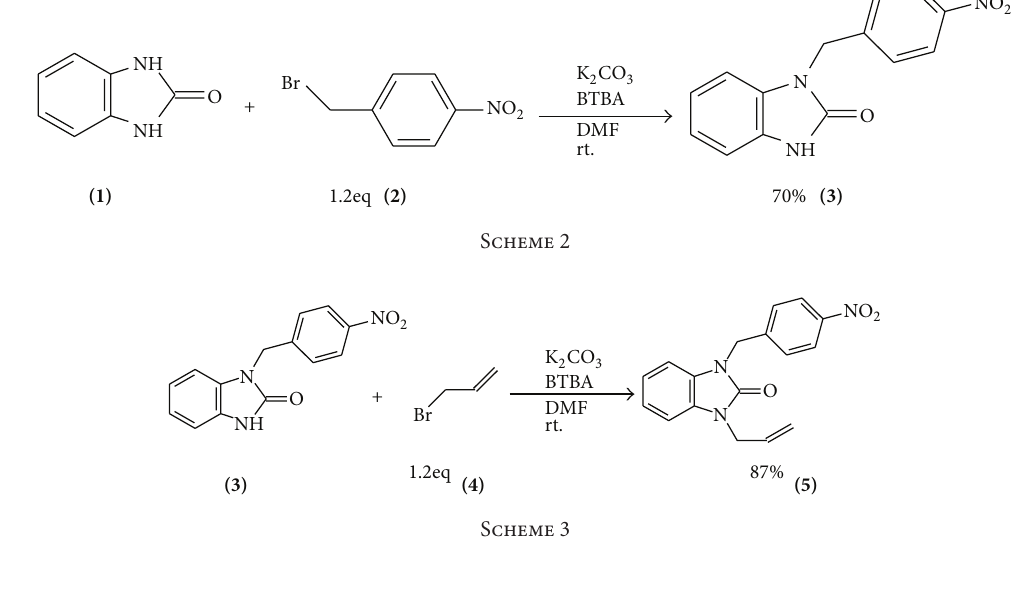
Table 1: Crystal data and structure refinement for 5